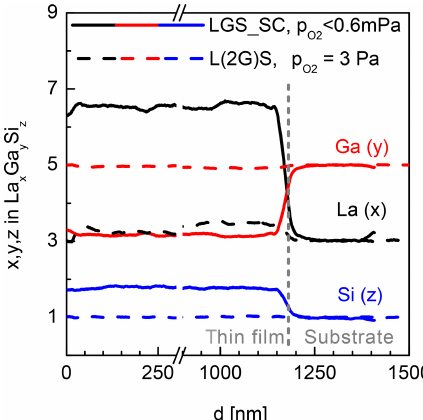
Figure 3. Ga, La and Si content determined by SNMS in the LGS films. Comparison of a film deposited from LGS_SC target under the best-achievable vacuum, i.e. 6 × 10 − 4 Pa (solid lines), and a film = 3Pa (dashed lines). Depo- grown from the L(2G)S target at p O 2 sition temperature is 600 ◦ C for both films.